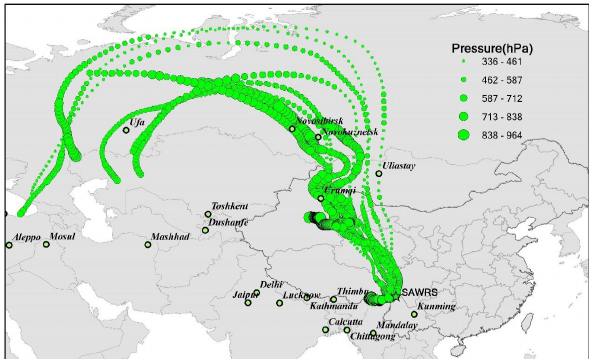
Figure 8. The back trajectories of air masses from 26 April to 2 May. High pressure means that the trajectory heights are low, and therefore the air masses can easily transport mercury emitted from the surface to